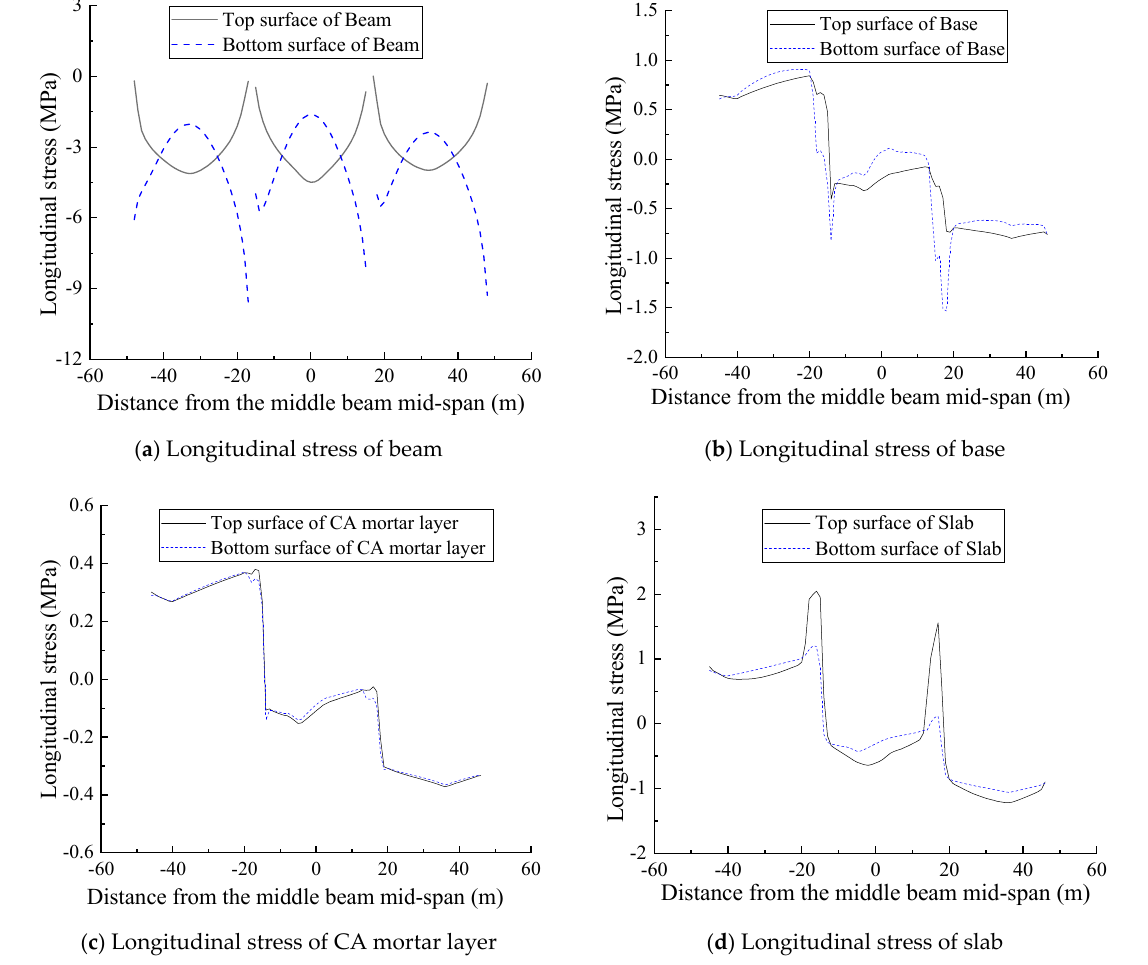
Figure 10. Longitudinal stress of structural layers under static load.